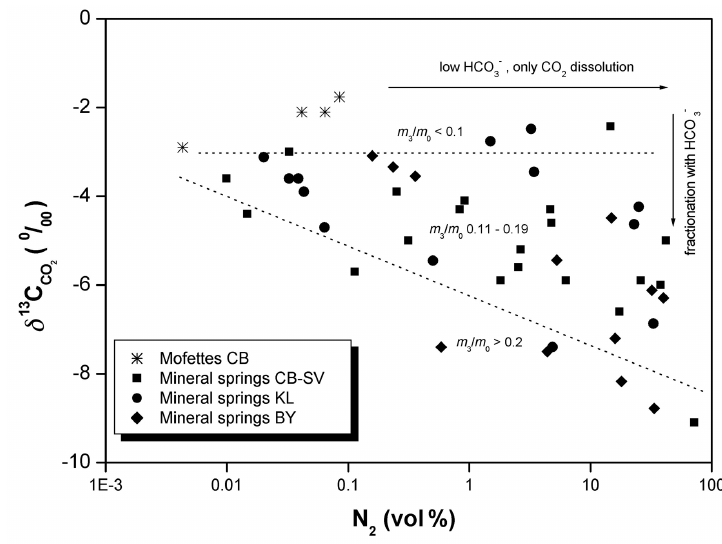
Fig. 6. Plot of N 2 content versus δ 13 C values displays the common variations in gas and isotope composition of gases from the Eger Rift area, e.g. , from the Cheb Basin/South Vogtland area (CB-SV), Konstantinovy Lázneˇ area (KL) and Bavaria (BY). These variations are caused by fractionation (CO 2 solution and HCO 3 – formation). In the case of waters with low TDS contents and without HCO 3 – formation, the fractionation can only take place with dissolved CO 2 and the isotopic heavy CO 2 remains therefore in the gas phase.